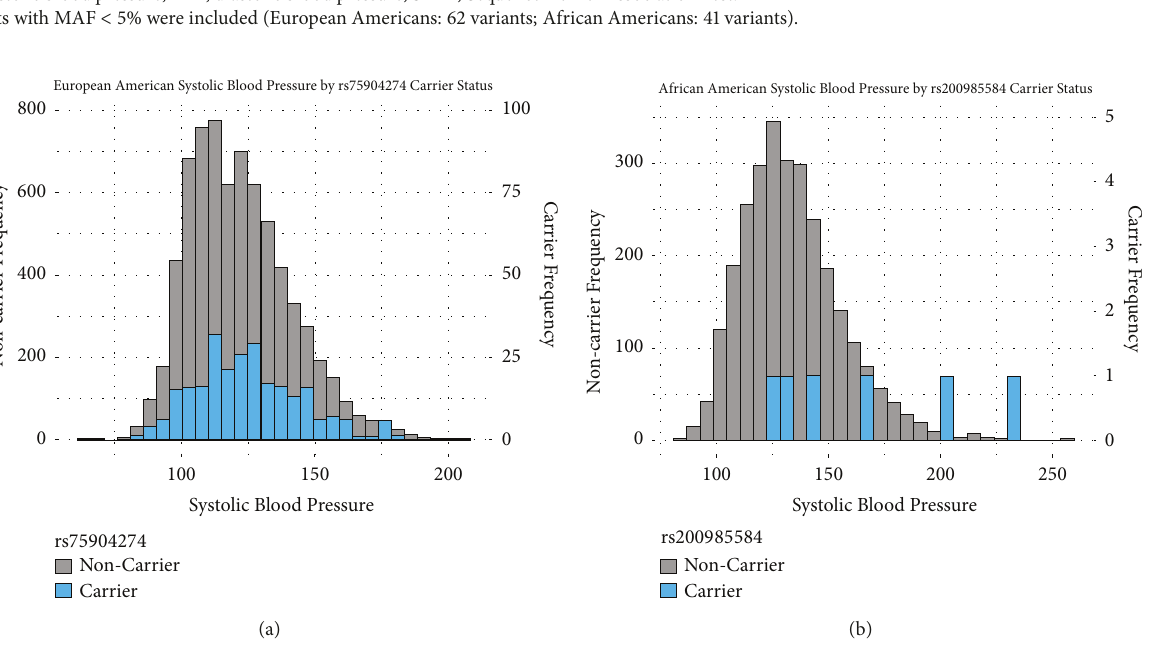
Figure 1: A histogram of minor allele carrier and noncarrier SBP values. Minor allele noncarrier frequency is shown on the left y-axis and minor allele carrier frequency is shown on the righty-axis. (a) shows the SBP values for European Americans who were either minor allele (T) carriersor noncarriersof rs75904274.(b)shows the SBP valuesfor AfricanAmericans whowere eitherminorallele(A)carriers ornoncarriers of